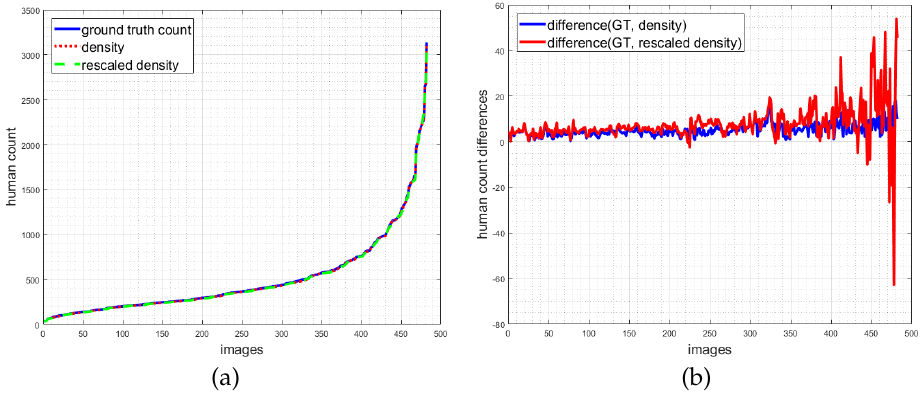
Figure 10. Count errors introduced during preprocessing. ( a ) Human count for all images based on ground truth head annotations, density estimate and downscaled density estimate. ( b ) Differences of ground truth head annotations and density estimates (blue), and differences of ground truth head annotations and downscaled density estimates